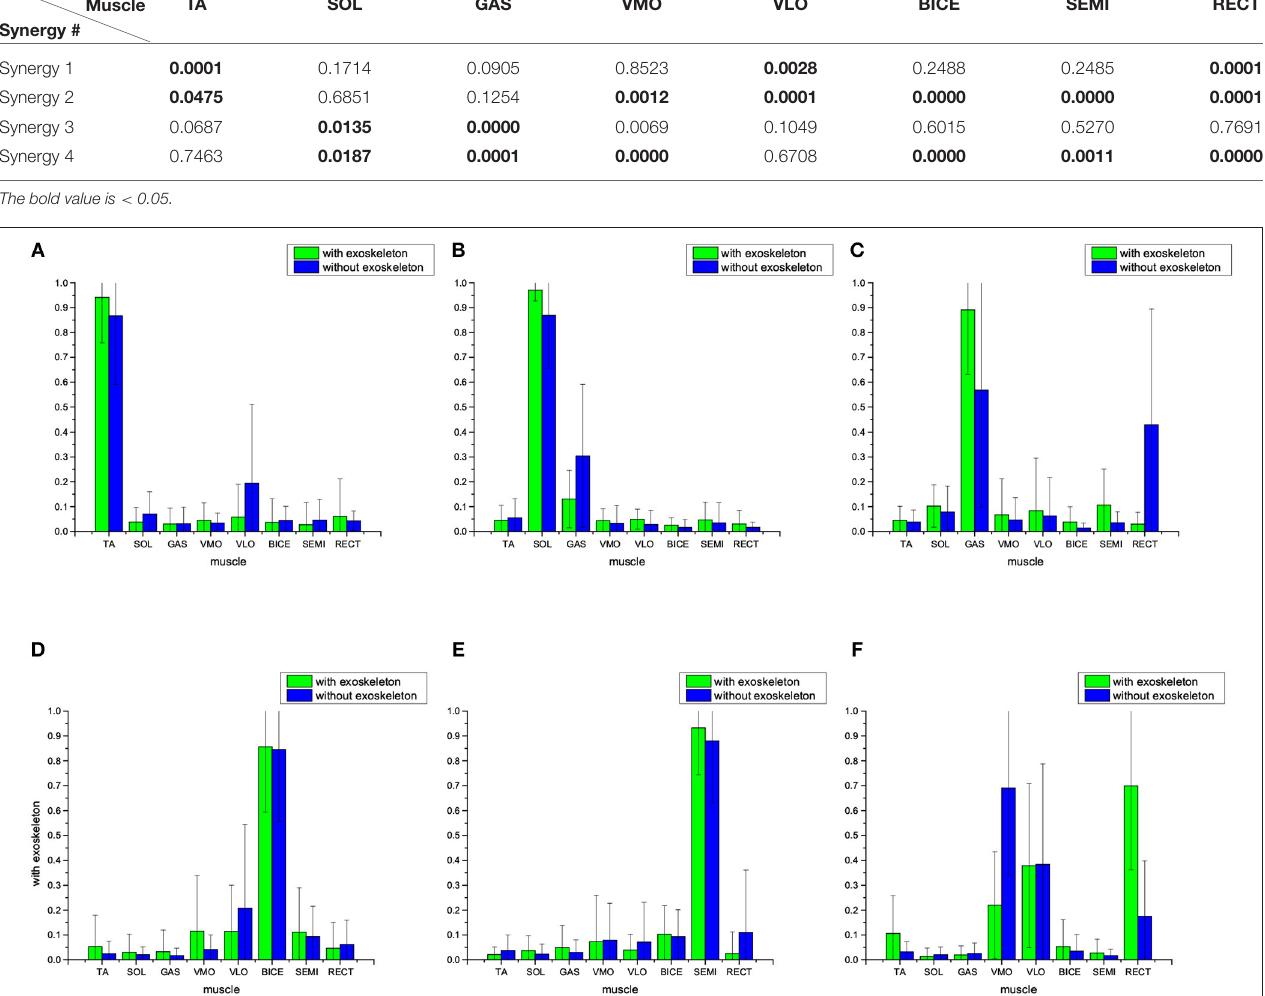
Frontiers in Neuroscience |